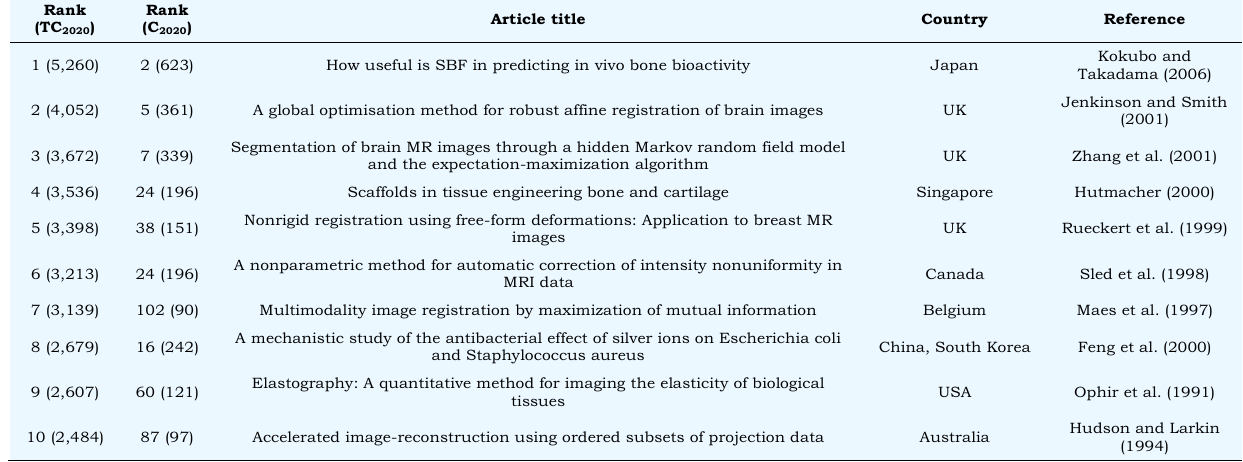
Table 5 The top 10 most impactful articles in 2020 in the Web of Science category of biomedical